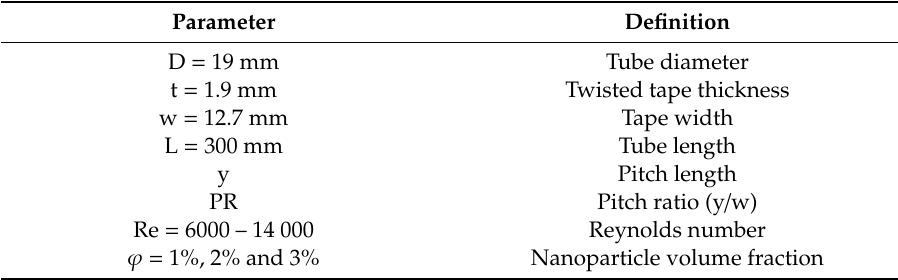
Figure 2. Smooth circular tube with twisted tape inserts. Table 1. Parameter